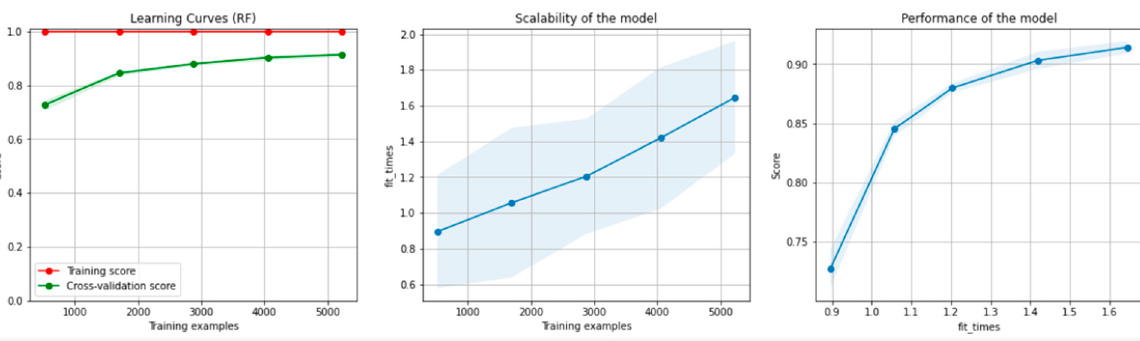
Figure 15. Learning curves, scalability and model performance for the RF algorithm, for the overlapping dataset. Table 7 presents the results of the kNN algorithm, applied on the overlapping da- taset. The highlighted values represent the highest scores obtained.